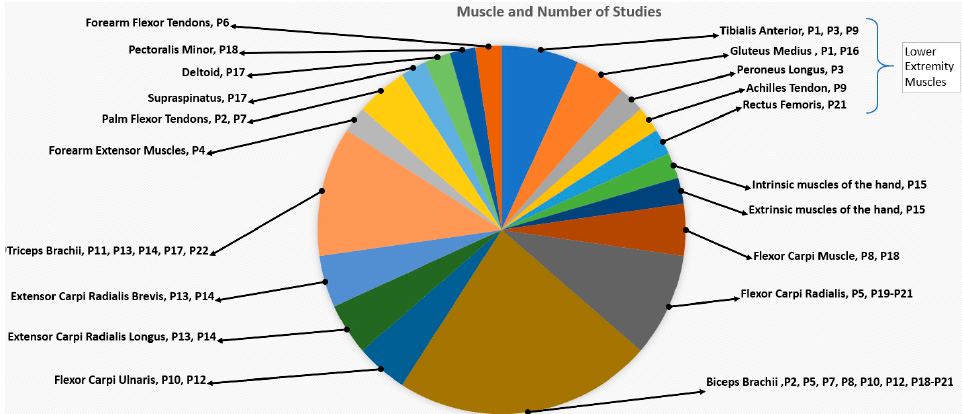
Figure 3. Muscles targeted for the FMV and studies using each muscle.